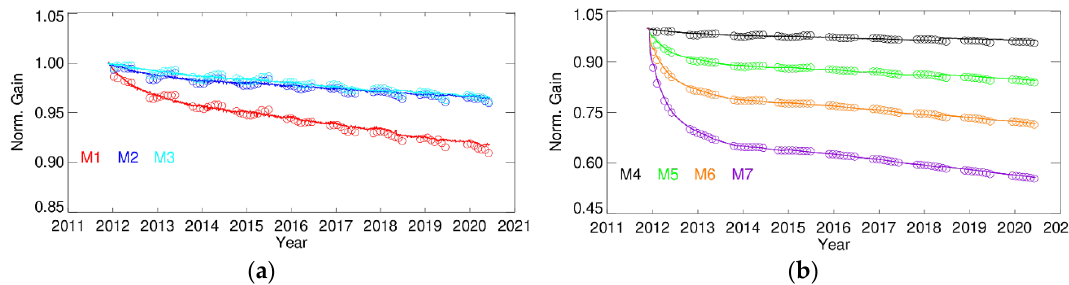
Figure 13. Normalized detector gains of S-NPP VIIRS bands M1-M3 ( a ) and bands M4-M7 ( b ) derived from SD (lines) and lunar (symbols) observations (band averaged, half-angle mirror (HAM) side 1).